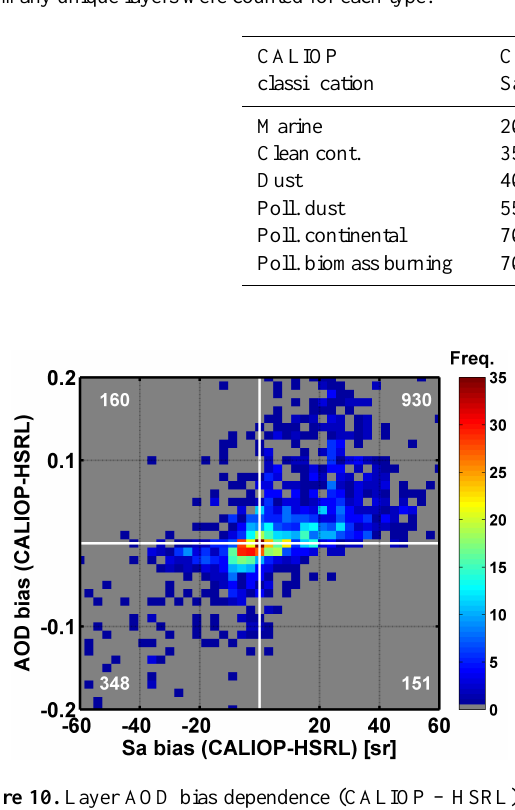
Figure 10. Layer AOD bias dependence (CALIOP – HSRL) as a function of layer lidar ratio bias (CALIOP – HSRL). Both day and night data are included, and the numbers represent the number of points in each